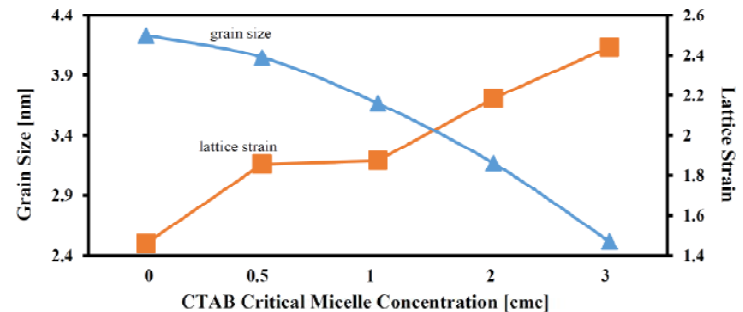
Fig. 5. Change process of lattice properties with increase in CMC values of CTAB. Figure 5 . Change process of lattice properties with increase in CMC values of CTAB